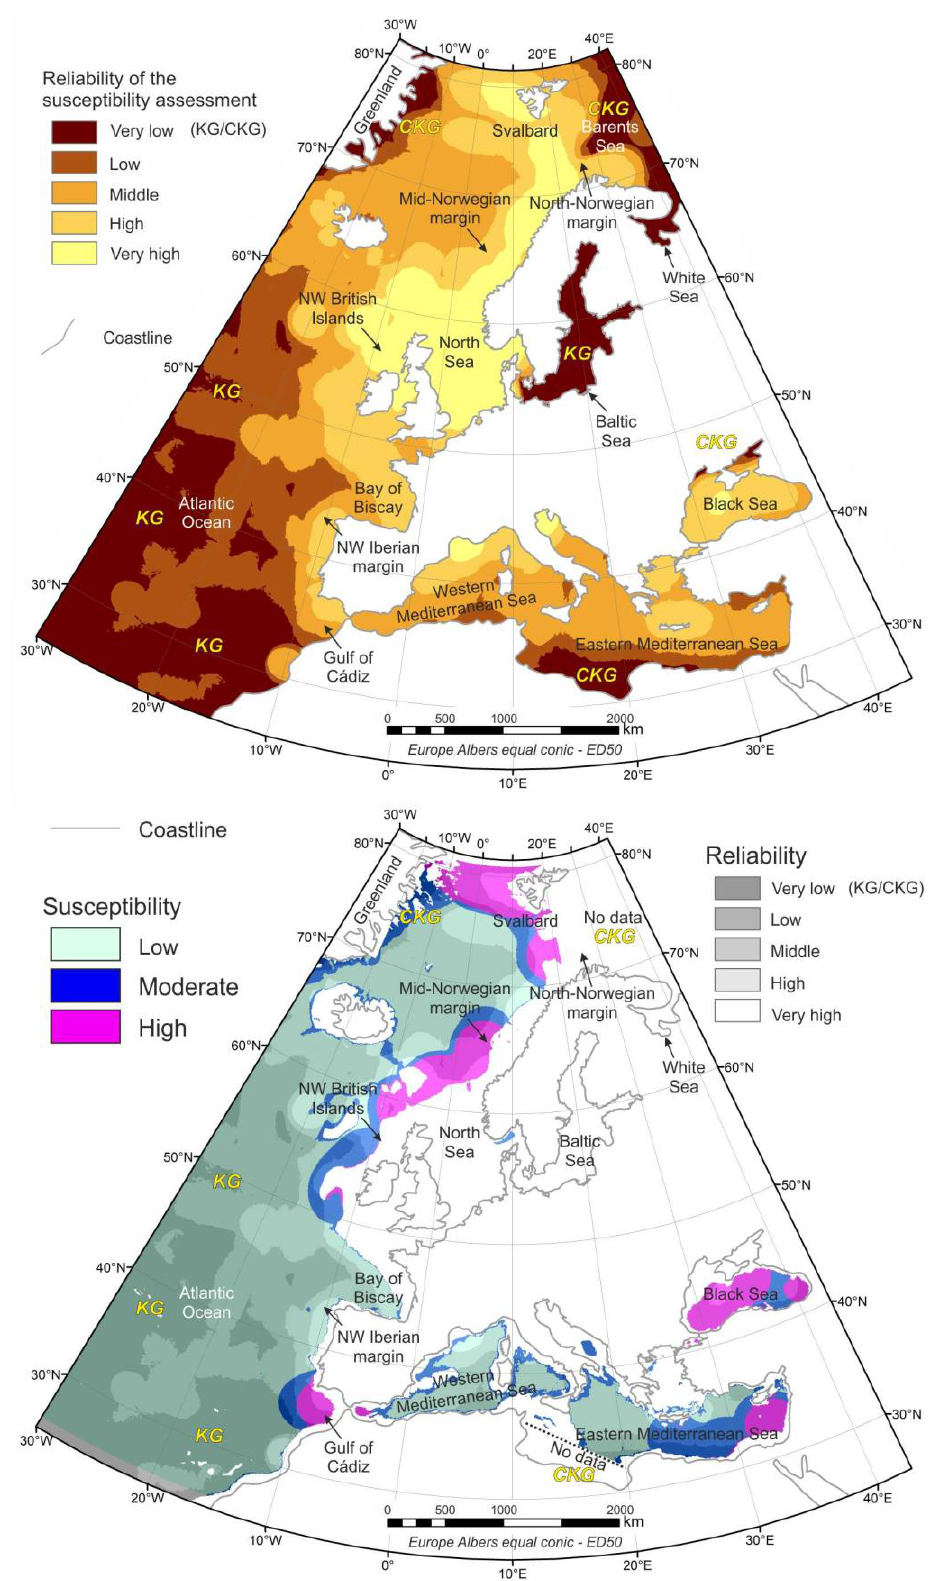
Figure 9. Reliability of the susceptibility assessment of hydrate presence on the European continental margins. ( a ) Reliability prediction in the inference of the susceptibility of the seafloor to the presence of hydrates. KG, global knowledge gap; CKG, global critical knowledge gap. ( b ) Reliability and susceptibility assessments